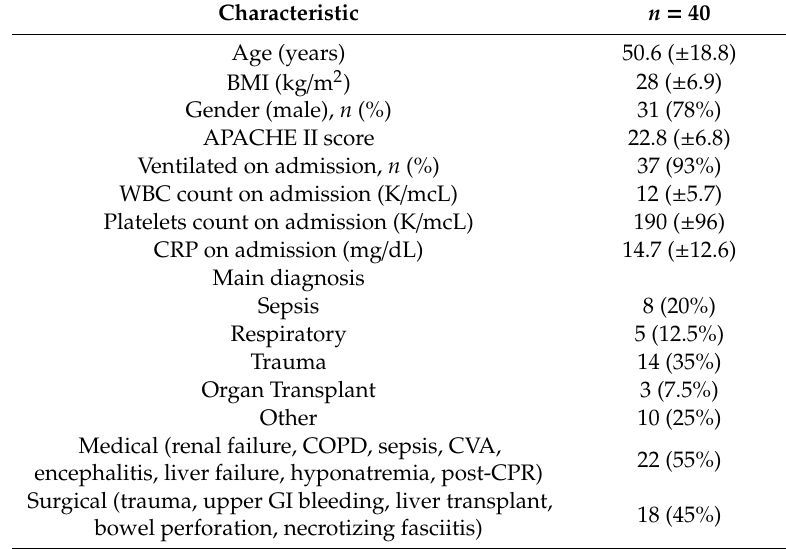
Table 1. Characteristics and laboratory data of patients admitted to the ICU unit, mean ( ± SD (standard